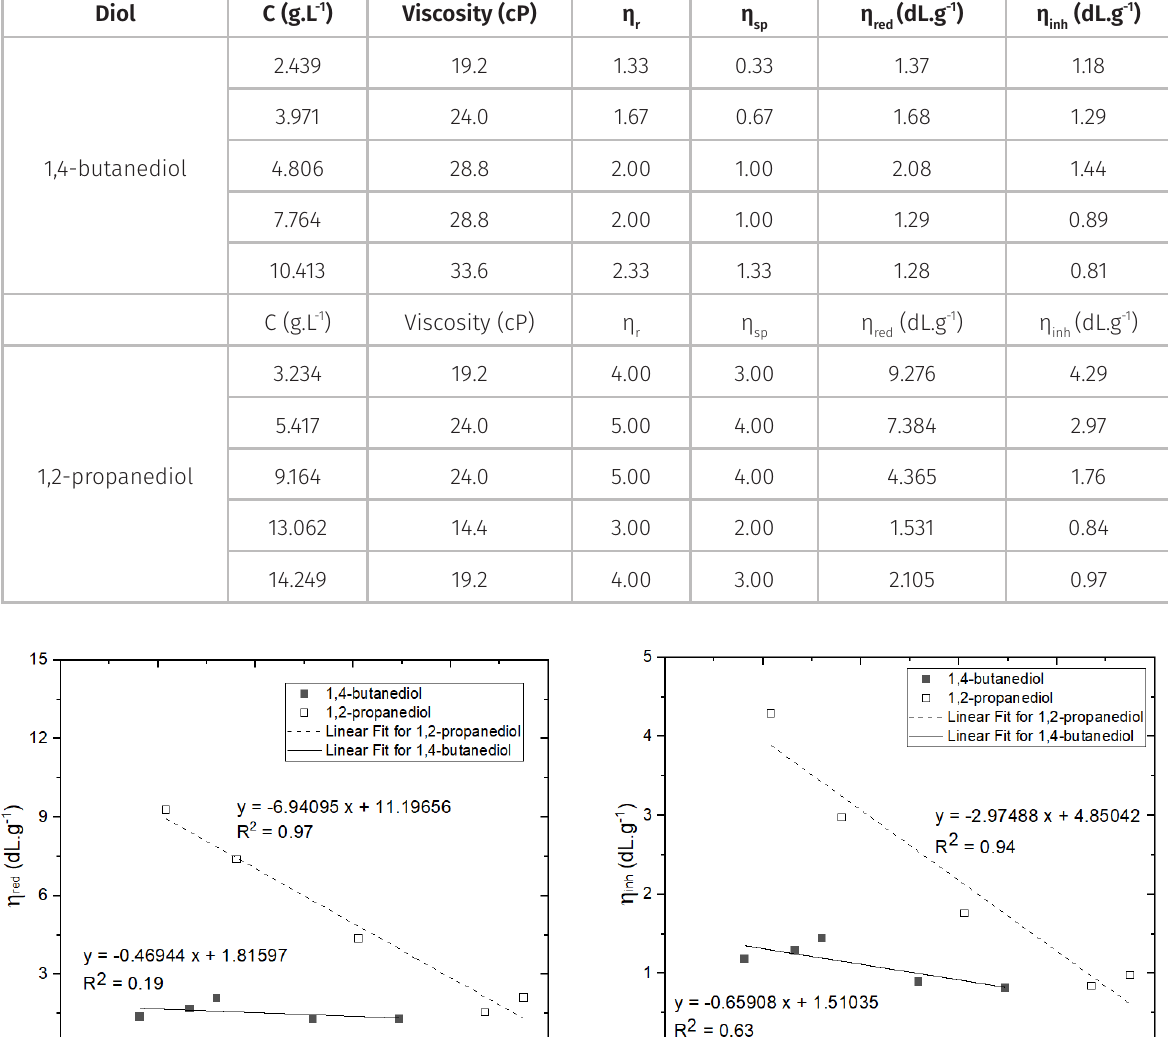
Table III. Relative, specific, reduced and inherent viscosity data for diluted 1,4-butanediol or 1,2-propanediol resin solutions. Diol C (g.L -1 ) Viscosity (cP) η